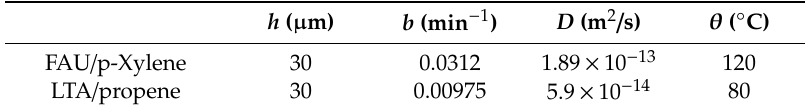
Figure 8. Exponential fit of the second branch marked “AIR” at the plot of Figure 5. Table 2. Fit results of Figures 7 and 8.